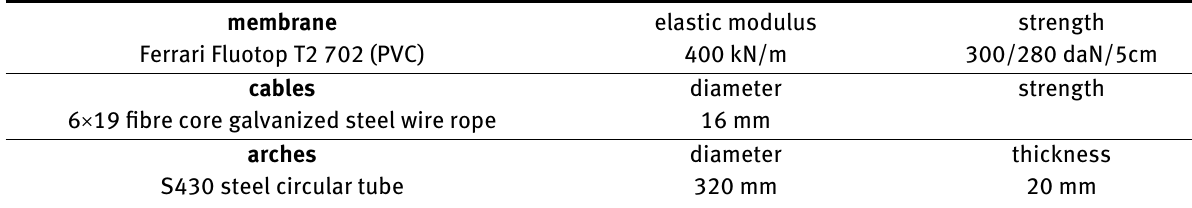
Table 2: Materials and section of the elements of the structure.